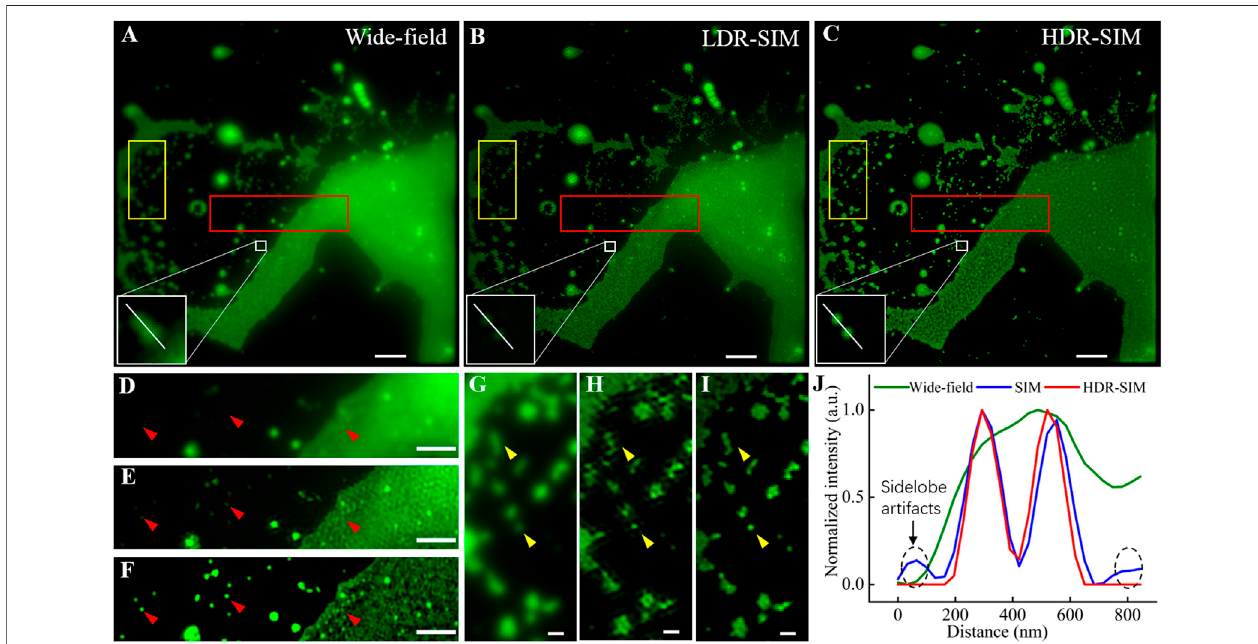
FIGURE 3 | Comparative images of fl uorescent beads, 100 nm in diameter, in wide- fi eld, traditional SIM, and HDR-SIM. (A) Wide- fi eld image. (B) SIM image reconstructed by fairSIM [21], corresponding to middle-exposure images (reconstruction parameters: strength 0.995, full-width-at-half-maximum (FWHM) of 3 cycles/ μ m,Wienerparameter (cid:2) 0.2). (C) HDR-SIMimage,thereconstructionparametersarethesameas (B) . (D – F) Zoom-inimagescorrespondingtotheregionmarkedbythe red boxes. (G – I) Zoom-in images corresponding to the region marked by the yellow boxes. (J) Intensity pro fi les along the white lines in (A – C) . Scale bar: (A – C) 3 μ m, (D – F) 1.5 μ m, and (G – I) 0.5 μ m. Gamma value: 0.5 for images in (A – C)